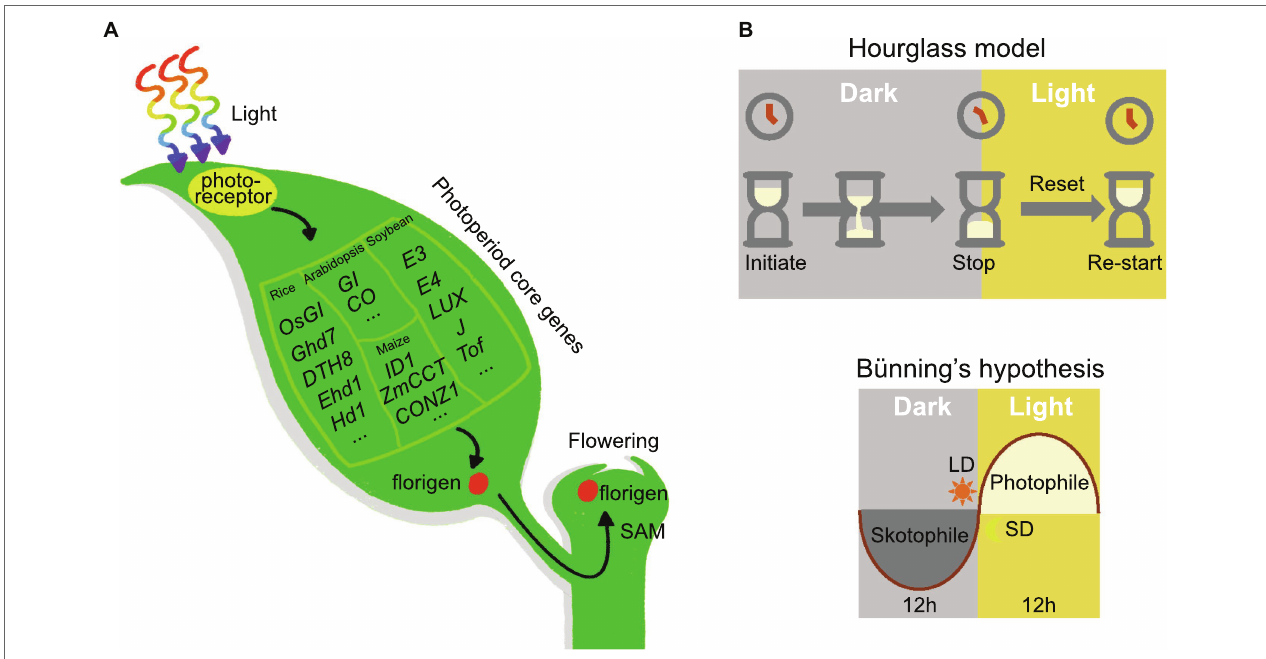
FIGURE 1 | Universality of photoperiod flowering signaling pathway in plant. (A) Photoreceptors receive the input signal, the photoperiod core network transmits the signal, and the florigen enacts the output signal. (B) Hourglass hypothesis. Timekeeping begins at night and stops after a period of darkness. This model requires exposure to light to turn the hourglass over and restart timing. Bünning’s hypothesis. Photoperiodic timekeeping depends on the circadian clock. For short-day plants, darkness is required during the photophile (light-requiring) phase; long-day plants demand light exposure in the skotophile (dark-requiring)